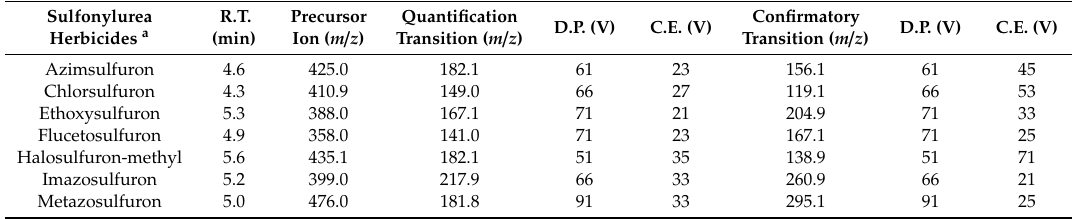
Table 1. LC-MS / MS parameter values used during the detection of selected sulfonylurea herbicides. Sulfonylurea R.T. Herbicides a